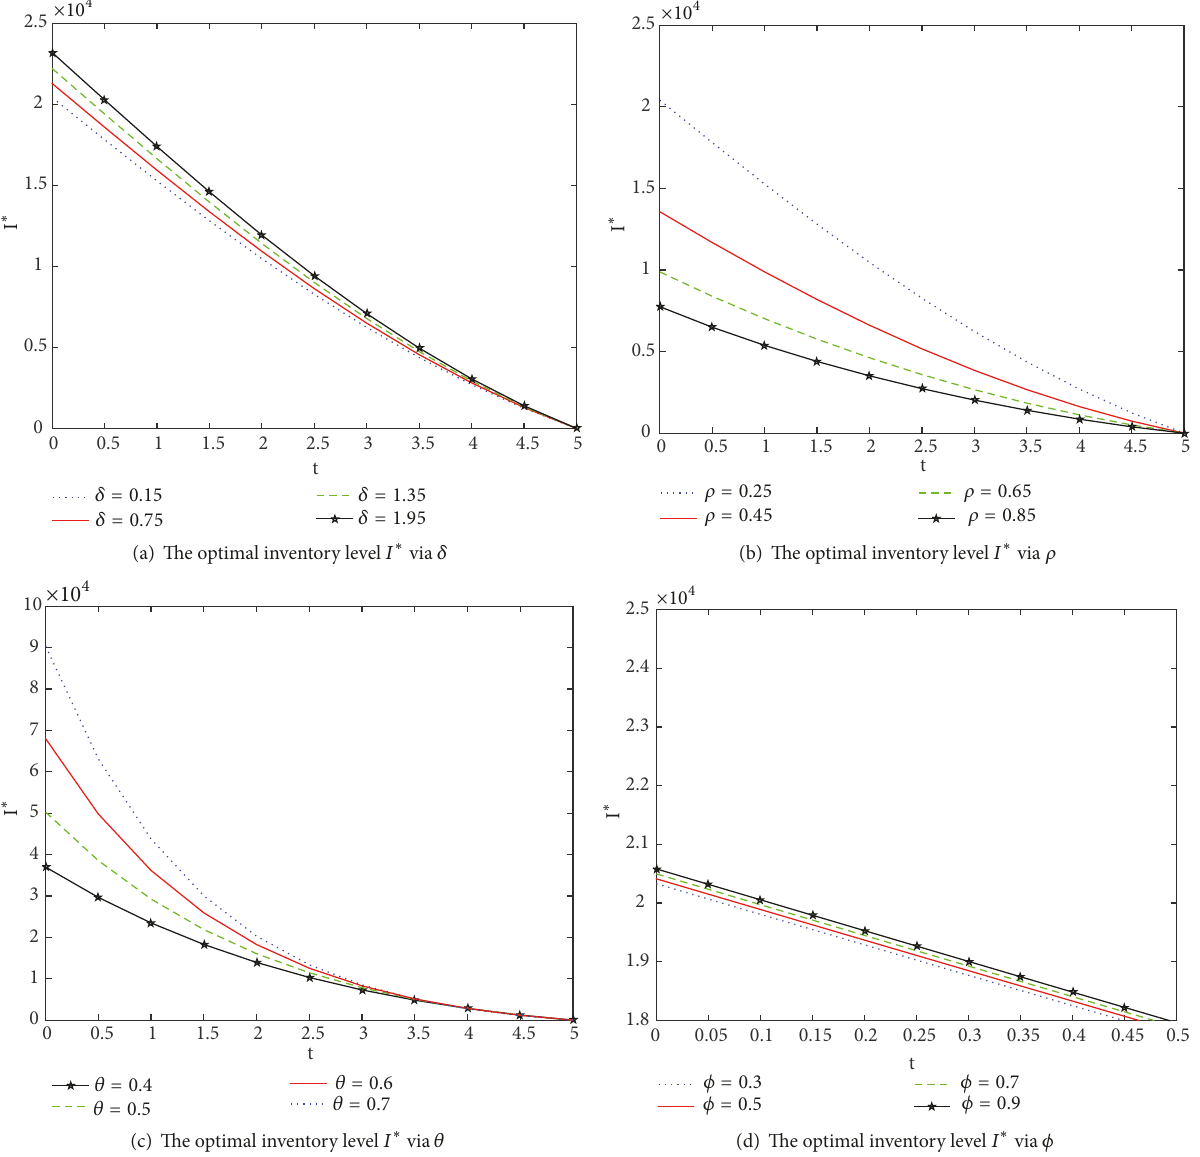
Figure 3: The impacts of parameters 𝛿,𝜌, 𝜃 , and 𝜙 on the optimal inventory level 𝐼 ∗